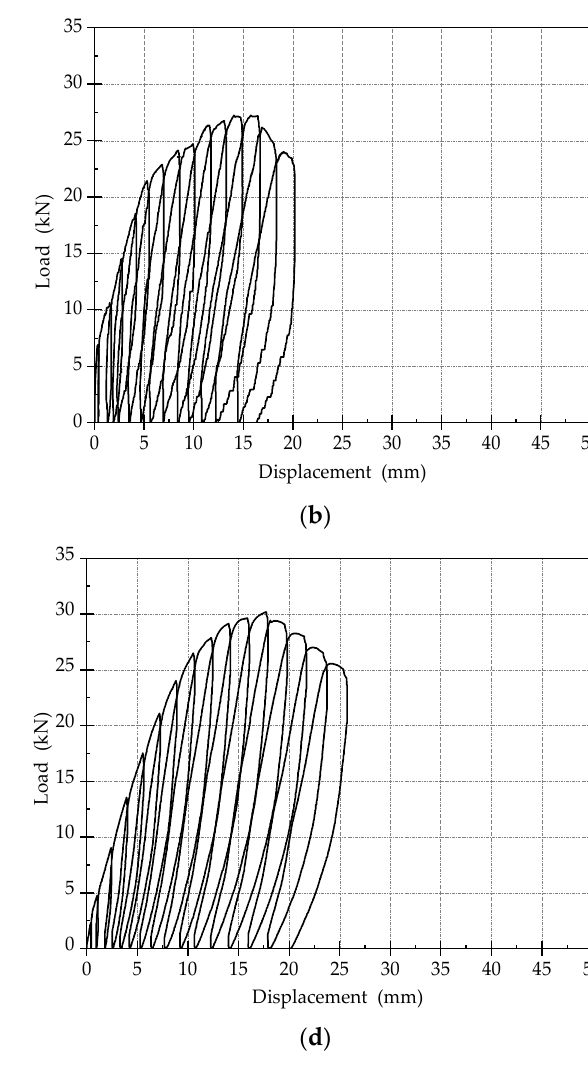
Figure 10. Load displacement curves ( a ) SJ-1; ( b ) SJ-2; ( c ) SJ-3; ( d ) SJ-4.